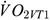
Correlations between A oxygen uptake at ventilatory threshold 1 (V˙O2VT1; y = 0.75x + 0.35; r = 0.72, p≤0.001), C heart rate at VT1 (HRVT1; y = 0.69x + 29.98; r = 0.67, p = 0.001) and E power output at VT1 (POVT1; y = 0.71x + 8.21; r = 0.73, p≤0.001), and Bland-Altman plots of the absolute differences between BV˙O2VT1, D HRVT1 and F POVT1 determined during maximal incremental test with short (STest) and long (LTest) time duration.In A, C and E, the dotted line represents the line of identity. In B, D and F, the light dotted line represents the bias from the mean difference, and the dark dotted line represents the upper and lower 95% limits of agreement.